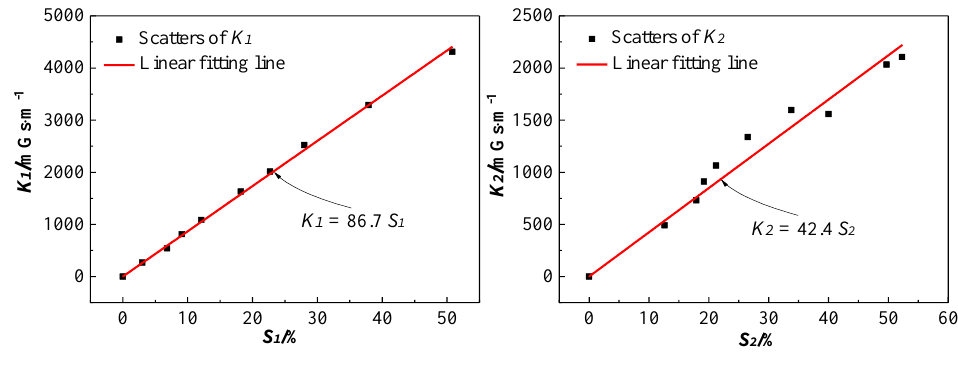
Figure. 12. Scatters and linear fitting line of S-K. Figure 12. Scatters and linear fitting line of S-K